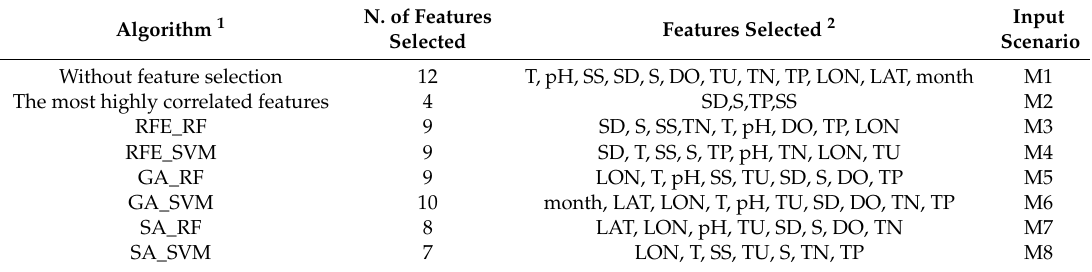
Table 3. Summarized results of feature selection using wrapper algorithms. Algorithm